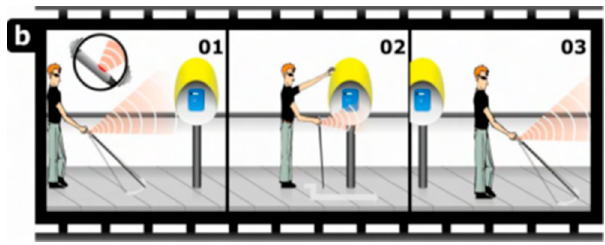
Figure 17. The proposed device for enhanced spatial sensitivity [35].